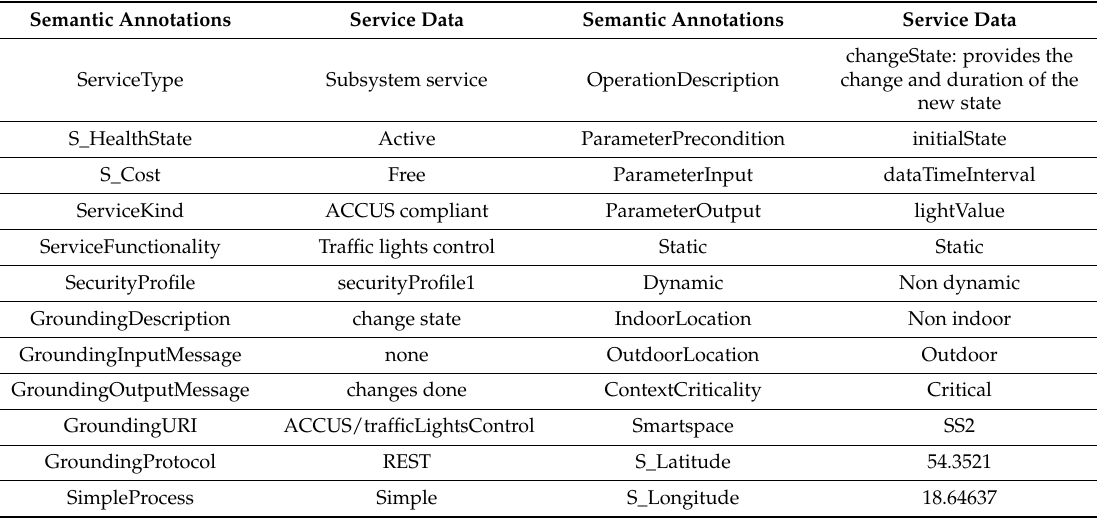
Table 2. Subsystem data and semantic